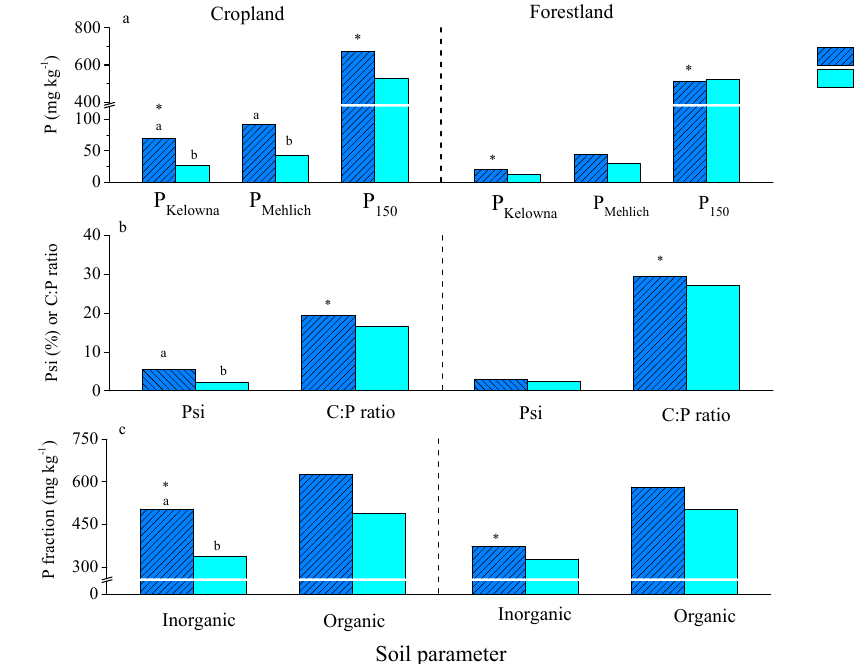
Figure 1. ( a ) The average concentrations of modified Kelowna extractable P (phosphorus), Mehlich-3 extractable P and P sorption index, ( b ) P saturation index and total C:P ratio, ( c ) inorganic P and organic P concentrations in 0–10 and 10–30 cm depths in studied cropland and forestland in shelterbelt systems in central Alberta. P Kelowna and P Mehlich are P extracted with modified Kelowna and Mehlich-3 extractions, P 150 , P sorption index, Psi, P saturation index. Di ff erent lower-case letters indicate a significant di ff erence between two depths for a particular soil parameter in cropland at p < 0.01 and asterisks indicate significant di ff erences of particular soil parameters between two land-use types in the 0–10 cm depth at p < 0.01 ( n = 6).